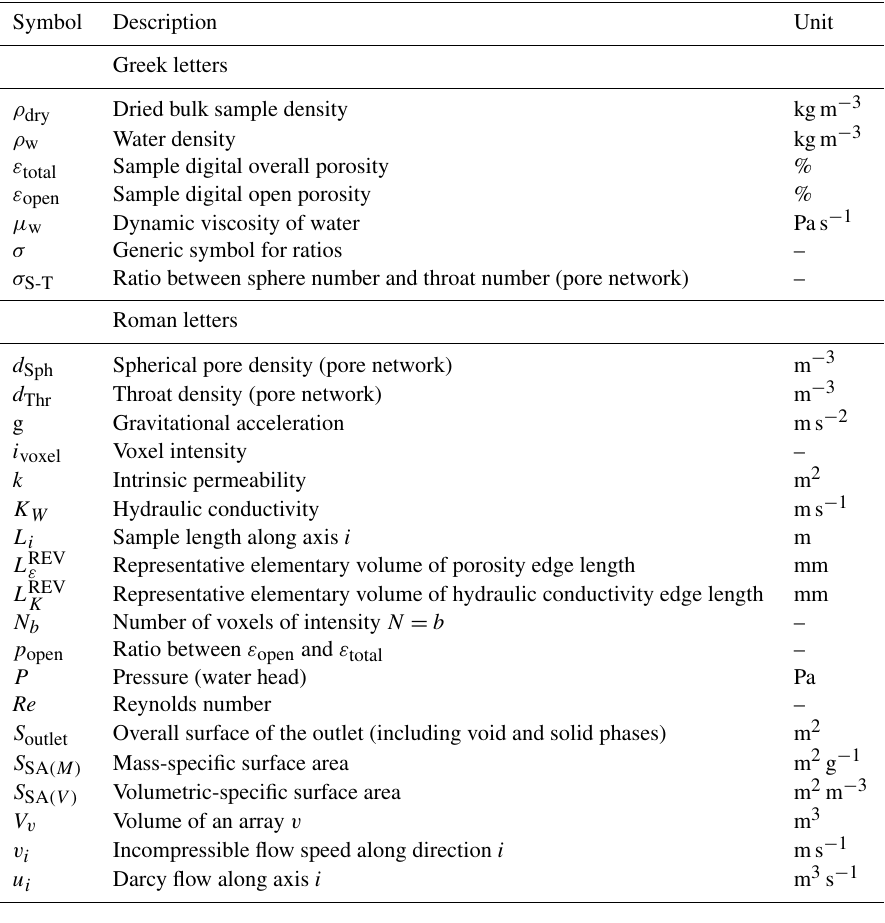
Table 1. Notation glossary.